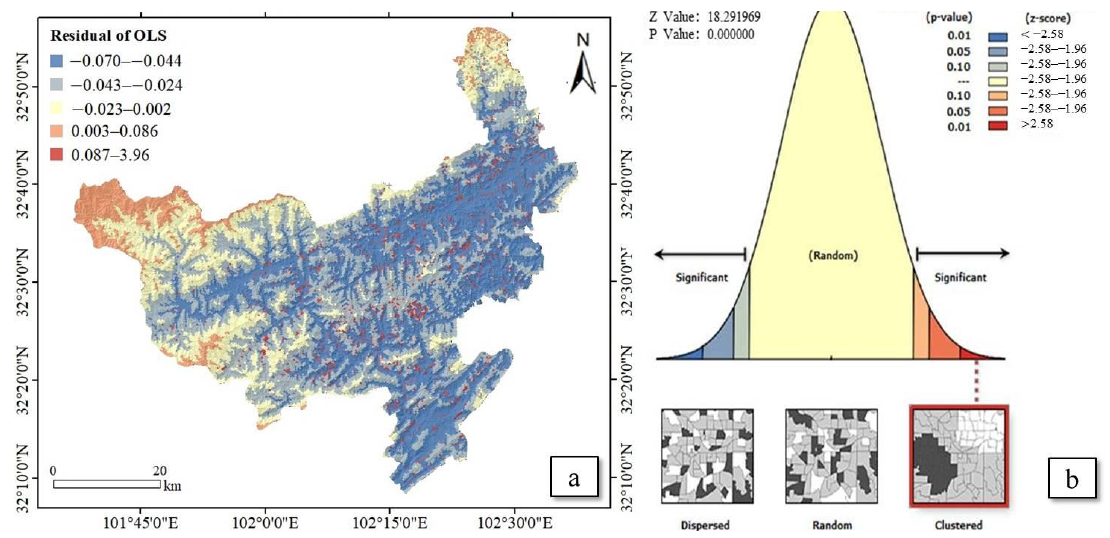
Figure 7. Diagram of ESDA: ( a ) residual distribution diagram based on OLS, ( b ) Moran’s index analysis of residual values.